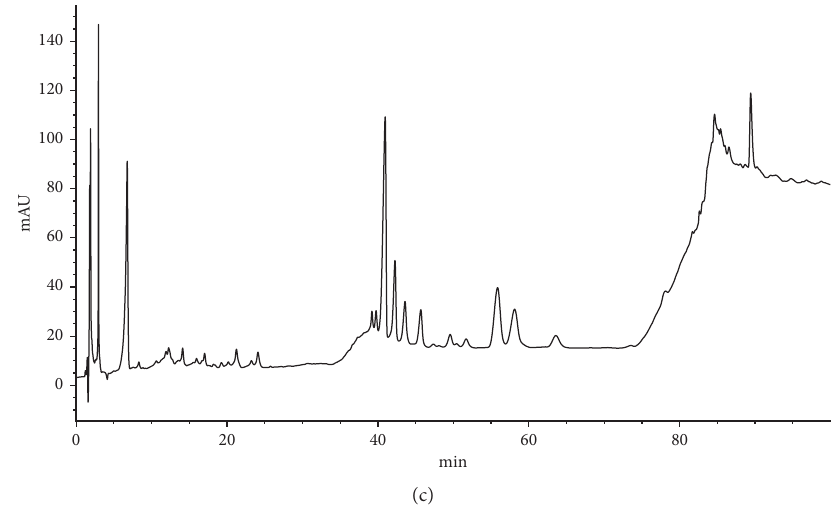
Figure 2: Chromatogram of Pulsatilla chinensis total saponin extract under different gradient elution conditions.